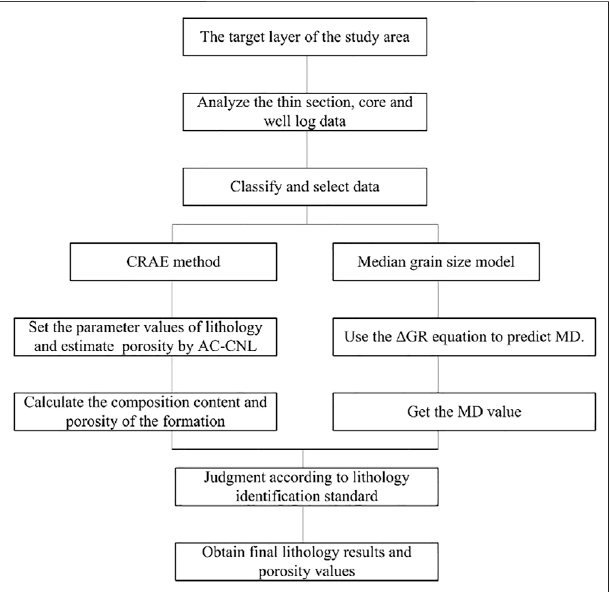
FIGURE 6 | Flowchart of lithology identi fi cation and porosity